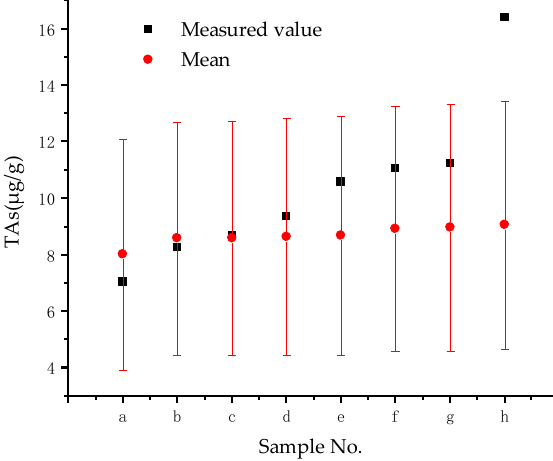
Figure 7. HSI predicted TAs and measured TAs with the standard deviation as error bars.